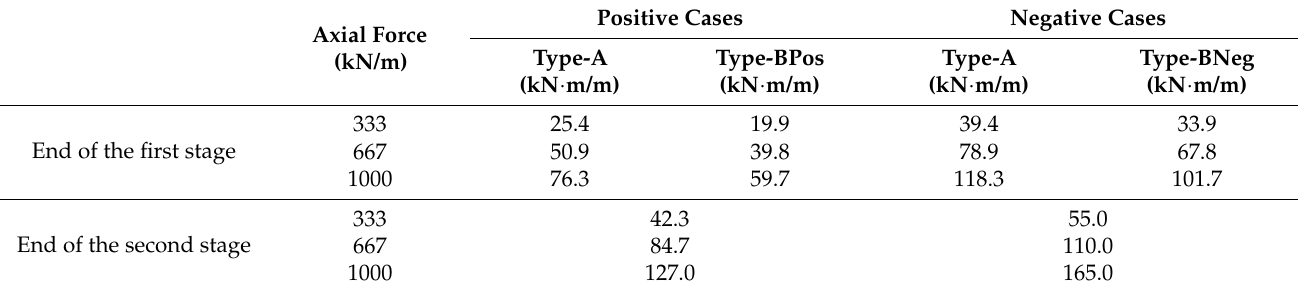
Table 6. Summary of the bending moments at the ends of different stages.